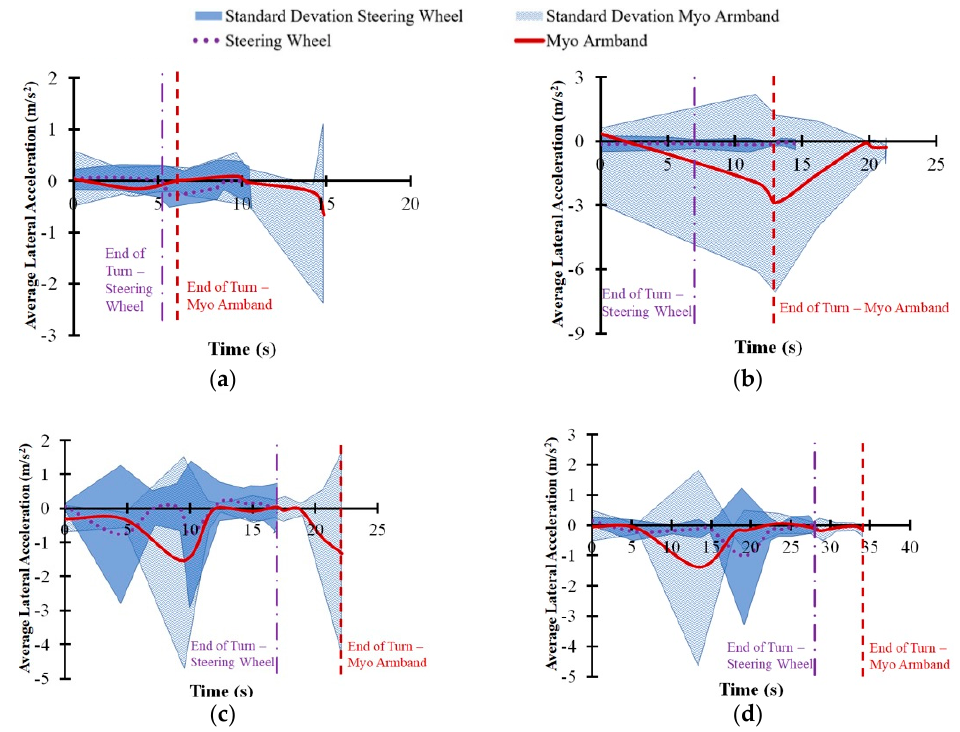
Figure 10. Average lateral acceleration on COMS vehicle for ( a ) 45° turn, ( b ) 90° turn, ( c ) narrow U-turn, and ( d ) wide U-turn. Vertical dashed lines indicate average times when drivers exited turns.